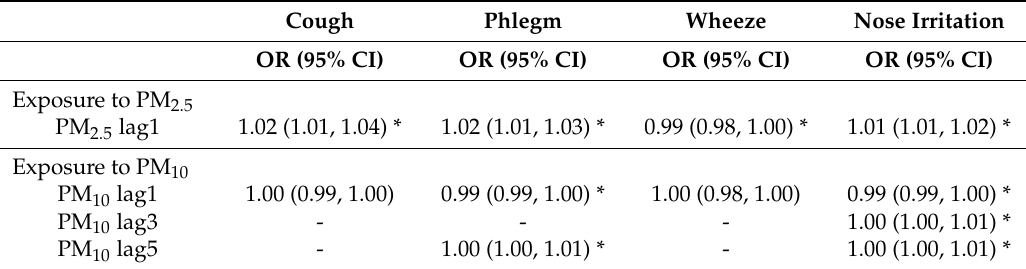
Table 5. Adjusted OR estimates of association between PM 2.5 and PM 10 and respiratory symptoms among participants from Freedom and Bauleni